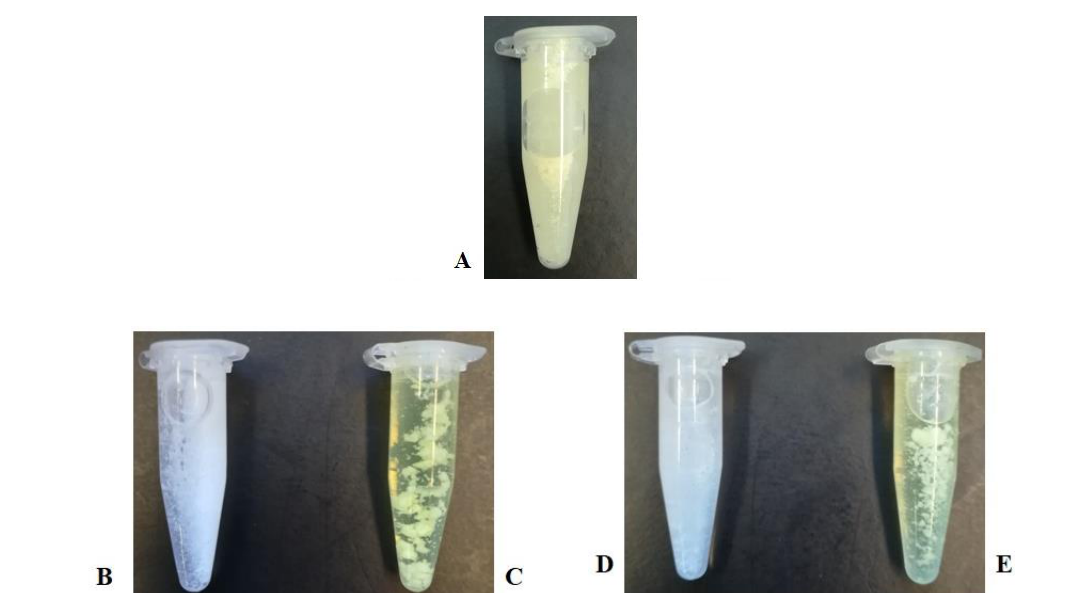
Figure 2. PBS-dispersed (1% v / v DMSO) ( A ) chrysin, ( B ) EPCL/PVAMCs, ( C ) ChrPCL/PVAMCs, ( D ) EPHB/PVAMCs, and ( E ) ChrPHB/PVAMCs.